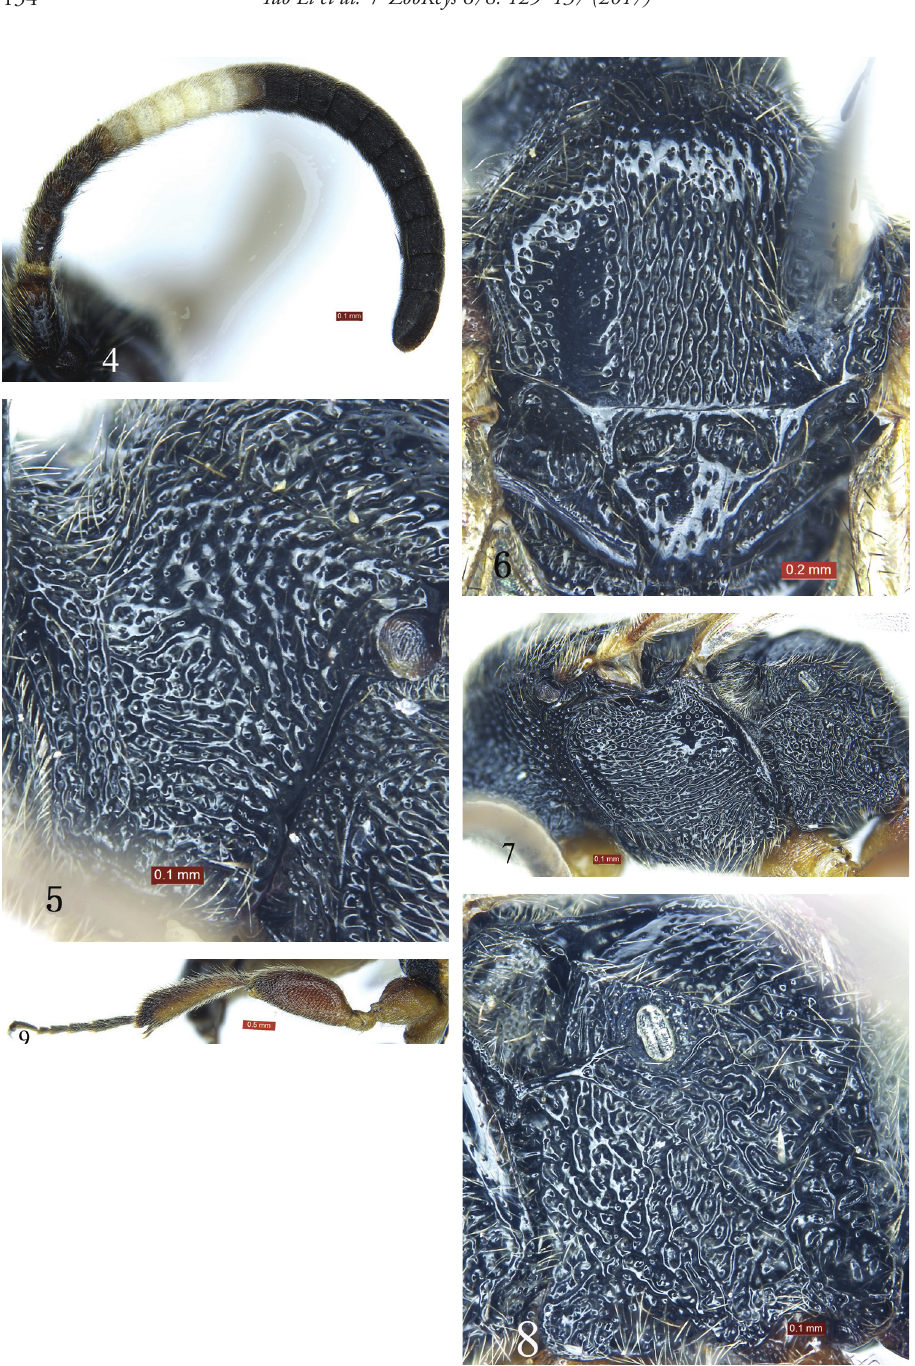
Figures 4–9. Glyphicnemis ganica sp. n. Holotype. Female. 4 Antenna 5 Pronotum, lateral view 6 Mes- oscutum and scutellum 7 Mesosoma, lateral view 8 Metapleuron 9 Hind